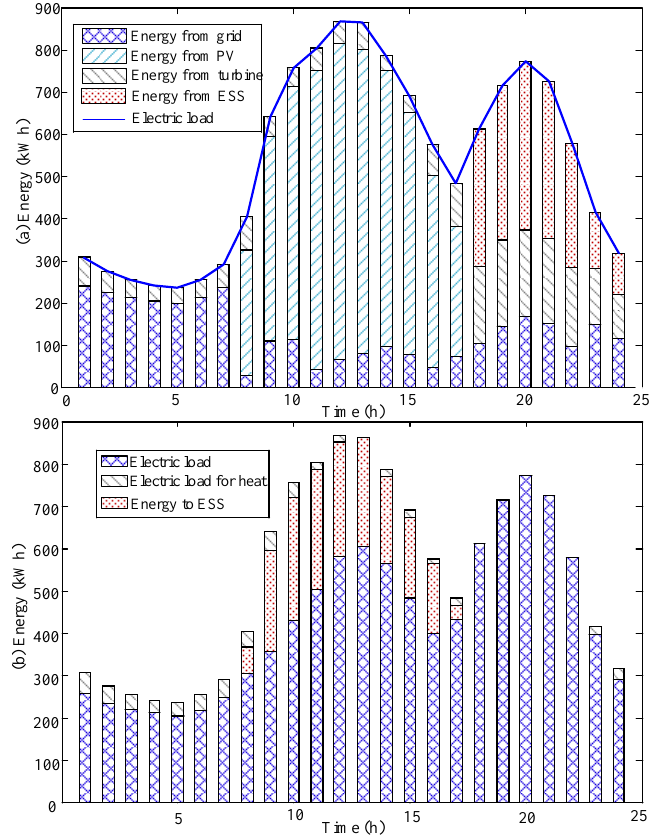
Figure 3. Optimal result of electrical energy: ( a ) is dispatching result of electricity energy resource; ( b ) is scheduling result of total electrical